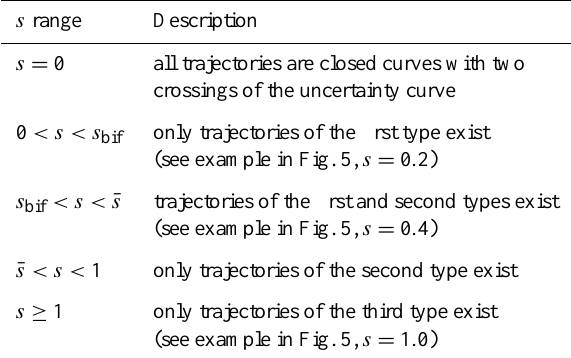
Table 1. System characteristics for various s